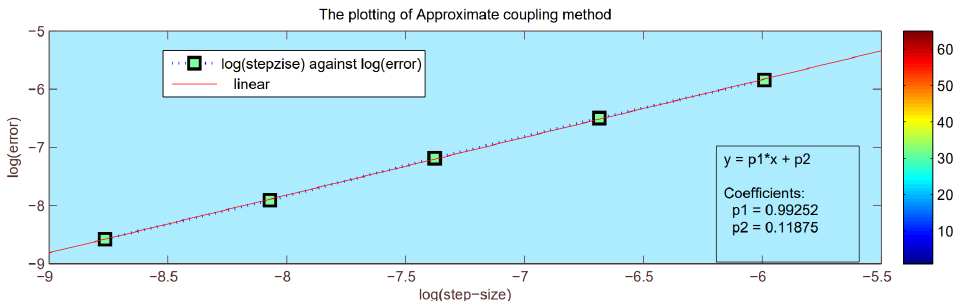
Figure 2. Plot of approximate